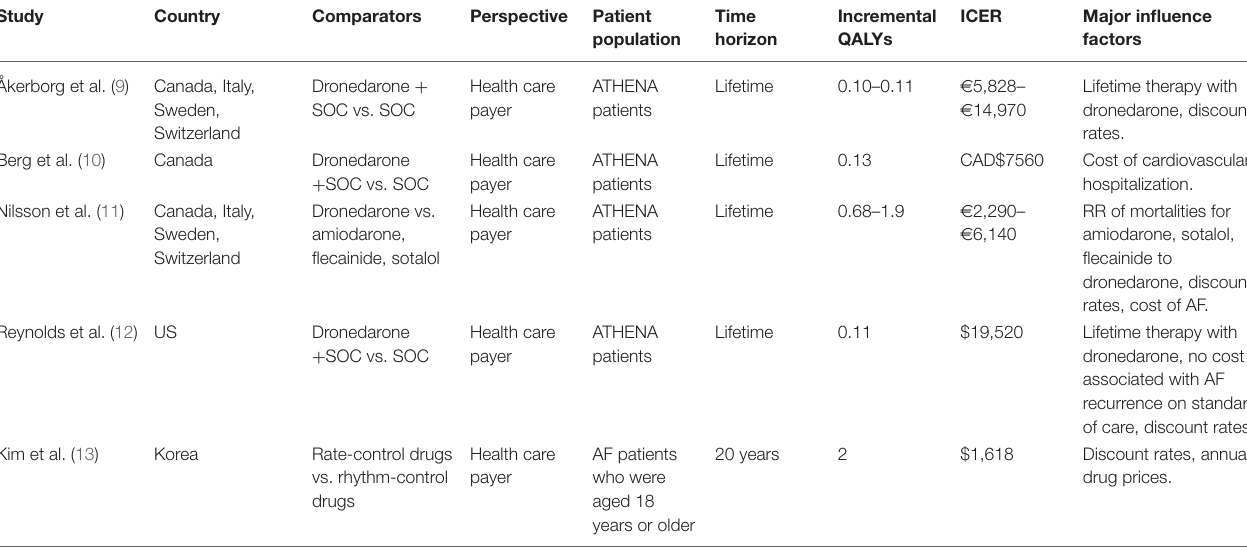
TABLE 2 | Information on the economic evaluations of